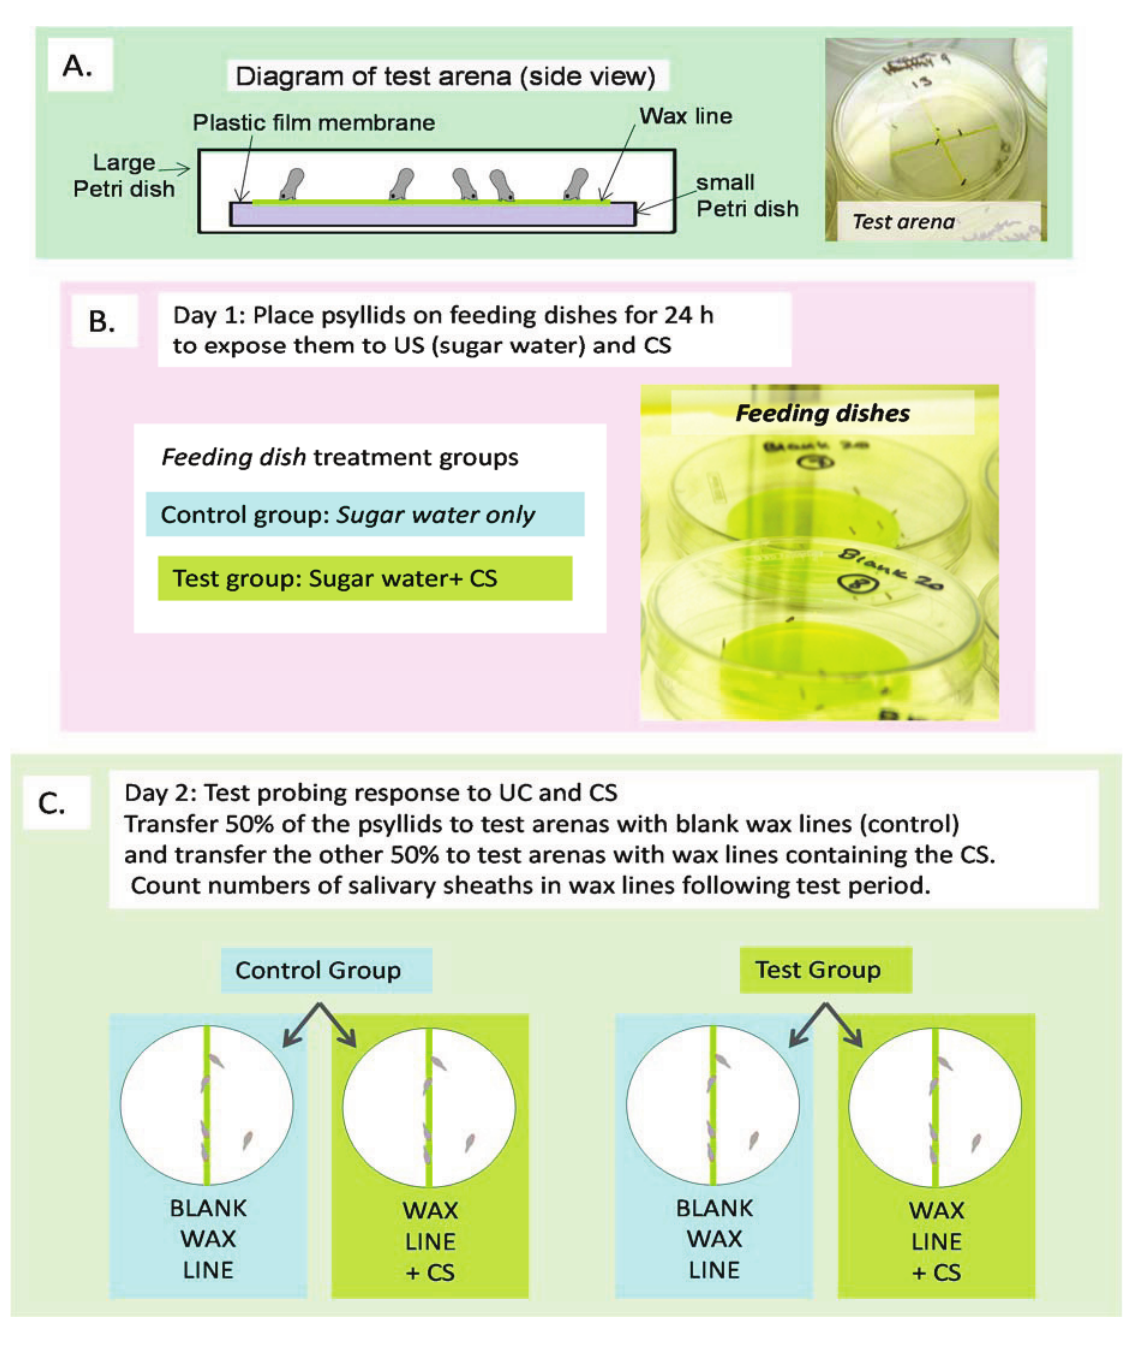
Figure 2. Schematic of experimental procedure. (A) Cross section view of test arena used in both innate and conditioned response tests. Photo insert shows psyllids on SPLAT